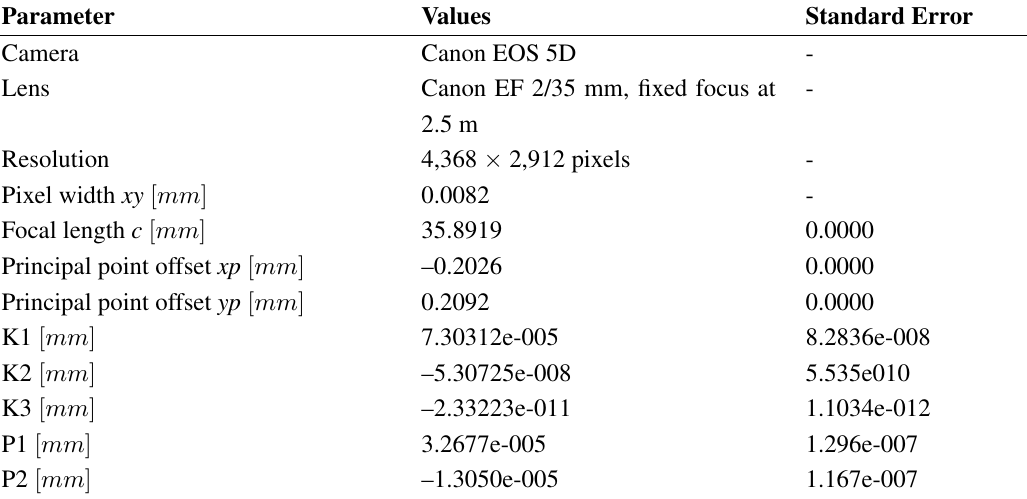
Table 2. Canon EOS 5D characteristics and calibration results. Calibration with Aicon